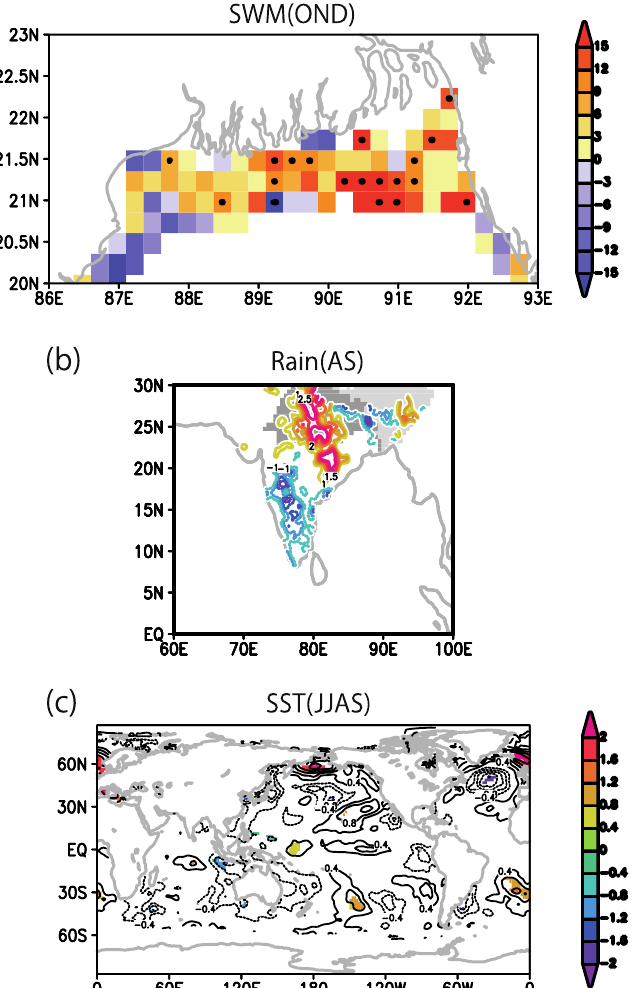
Figure 8. Composite map of high-Satellite Water Marker (SWM) in 1997–2005 (period of insignificant ENSO–monsoon relationship; see Figure 5). Composite maps defined by high and low (exceeding ±1𝜎 ) years of October–December (OND) SWM index over the north BoB (20–23° N, 85–95° E). ( a ) SWM anomalies in OND, ( b ) normalized August–September (AS) rainfall anomaly (only ±1σ, ±1.5σ … are contoured), and ( c ) same-season June–September (JJAS) SST anomaly. Only areas above 90% significance are shown.